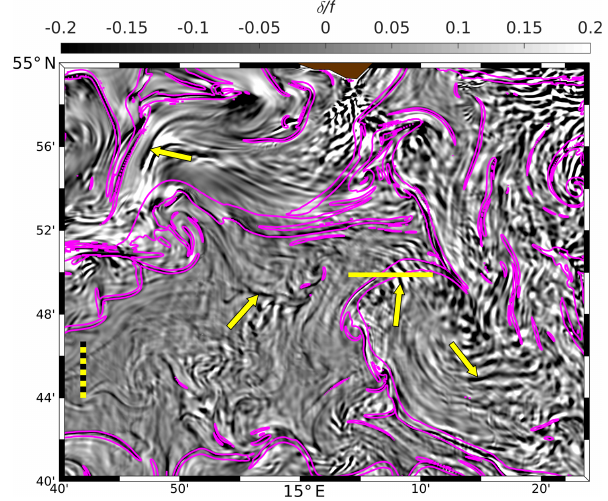
Figure 8. R100, 26 June: zoom of f -scaled horizontal divergence δ (grayscale image; for the position of the zoomed area see Fig. 7c). Bright areas indicate divergent flow, and convergences appear dark. The magenta lines show the |∇ ρ | = 10 − 4 kgm − 4 contours. The yellow arrows likely mark internal wave packages as discussed in the text. The horizontal yellow line is the position of the section shown in Fig. 9. The dashed ruler represents a distance of